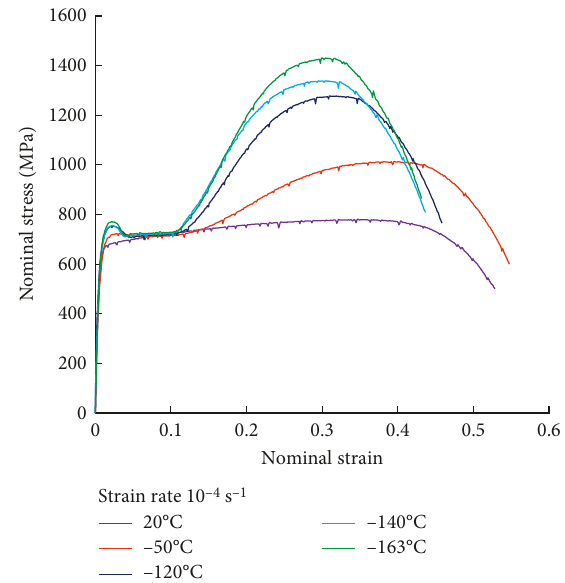
Figure 3: Temperature-dependent stress-strain relation of stainless steel.